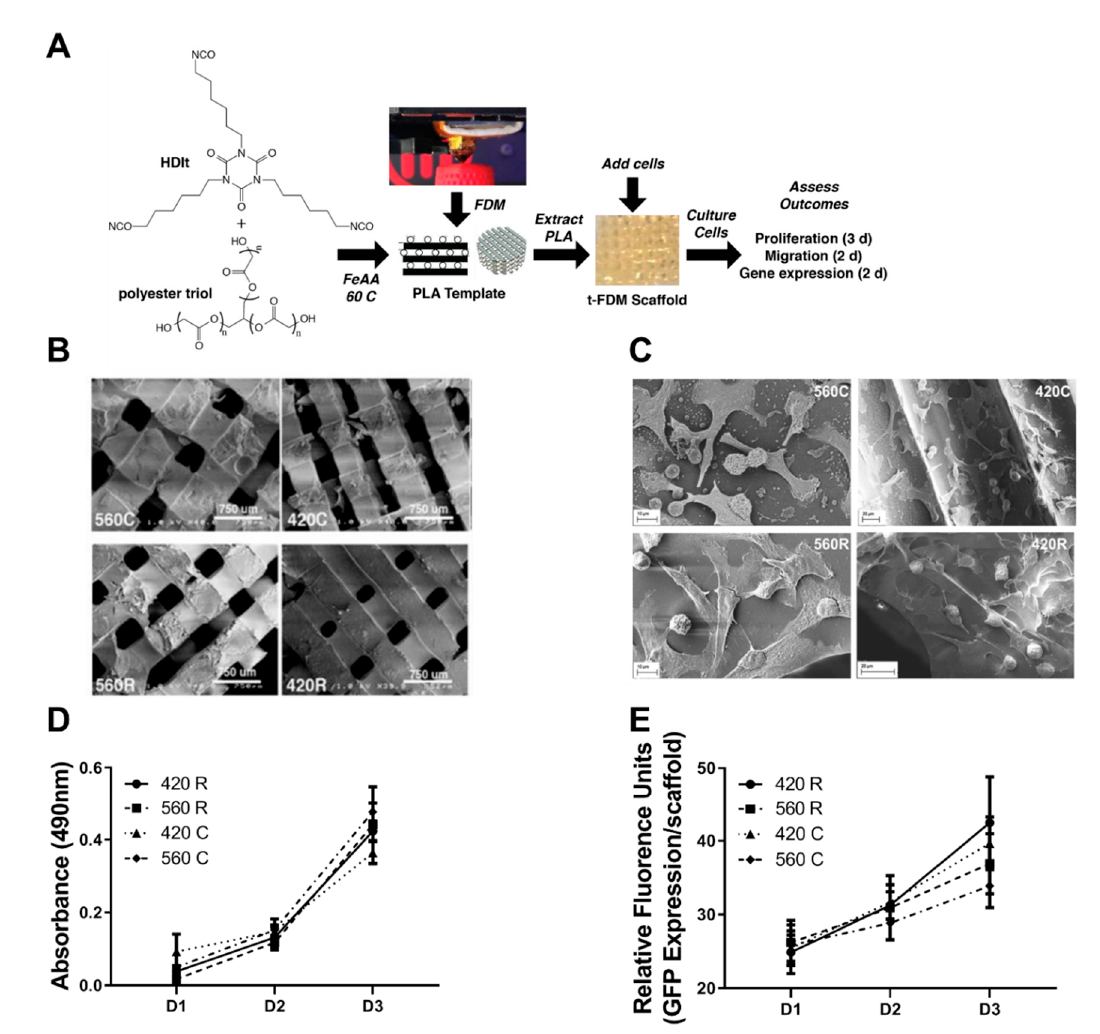
Figure 1. Fabrication schematic for 3D t-FDM scaffolds and cellular activity on the scaffolds. ( A ) Hexamethylene diisocyanate trimer (HDIt) was mixed with a poly( ε -caprolactone-co-glycolide) triol and stannous octoate catalyst and poured into a poly(lactic acid) (PLA) mold fabricated by a MakerBot Replicator 2 fused-deposition modeling (FDM) 3D printer. After curing overnight, the PLA mold was extracted via solvent leaching in dichloromethane for 24 h. The resulting scaffold was washed with DI water and prepared for cell culture. ( B , C ) Representative scanning electron microscopy (SEM) image of the 3D t-FDM scaffolds ( B ) and of cell attachment on 3D scaffolds ( C )—560µm compliant (560C), 420µm compliant (420C), 560µm rigid (560R), and 420µm rigid (420R). ( D ) Metabolic activity of MDA-MB-231 tumor cells cultured on 3D scaffolds measured by the MTS assay corroborates no variation of metabolic expression over a time period (days- D1, D2 and D3). ( E ) Proliferation of MDA-MB-231 tumor cells on 3D scaffolds measured as fluorescence expression of GFP, demonstrates no statistical differences between 3D scaffold groups over a time period (days- D1, D2 and D3).